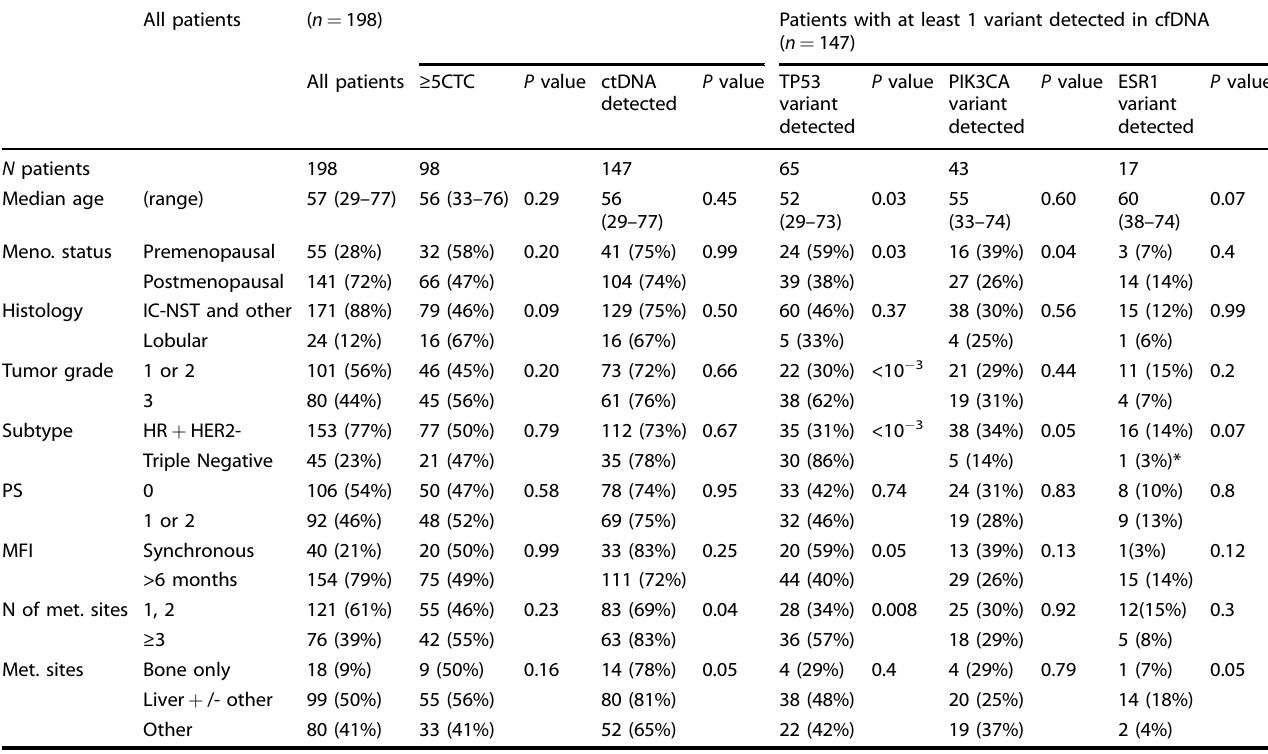
Table 1. Patient characteristics and association with circulating tumor biomarkers at baseline. All patients